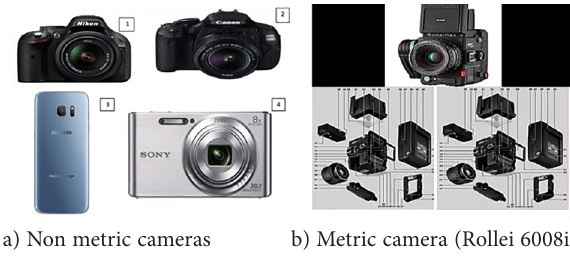
Figure 3. Types of cameras used in the research